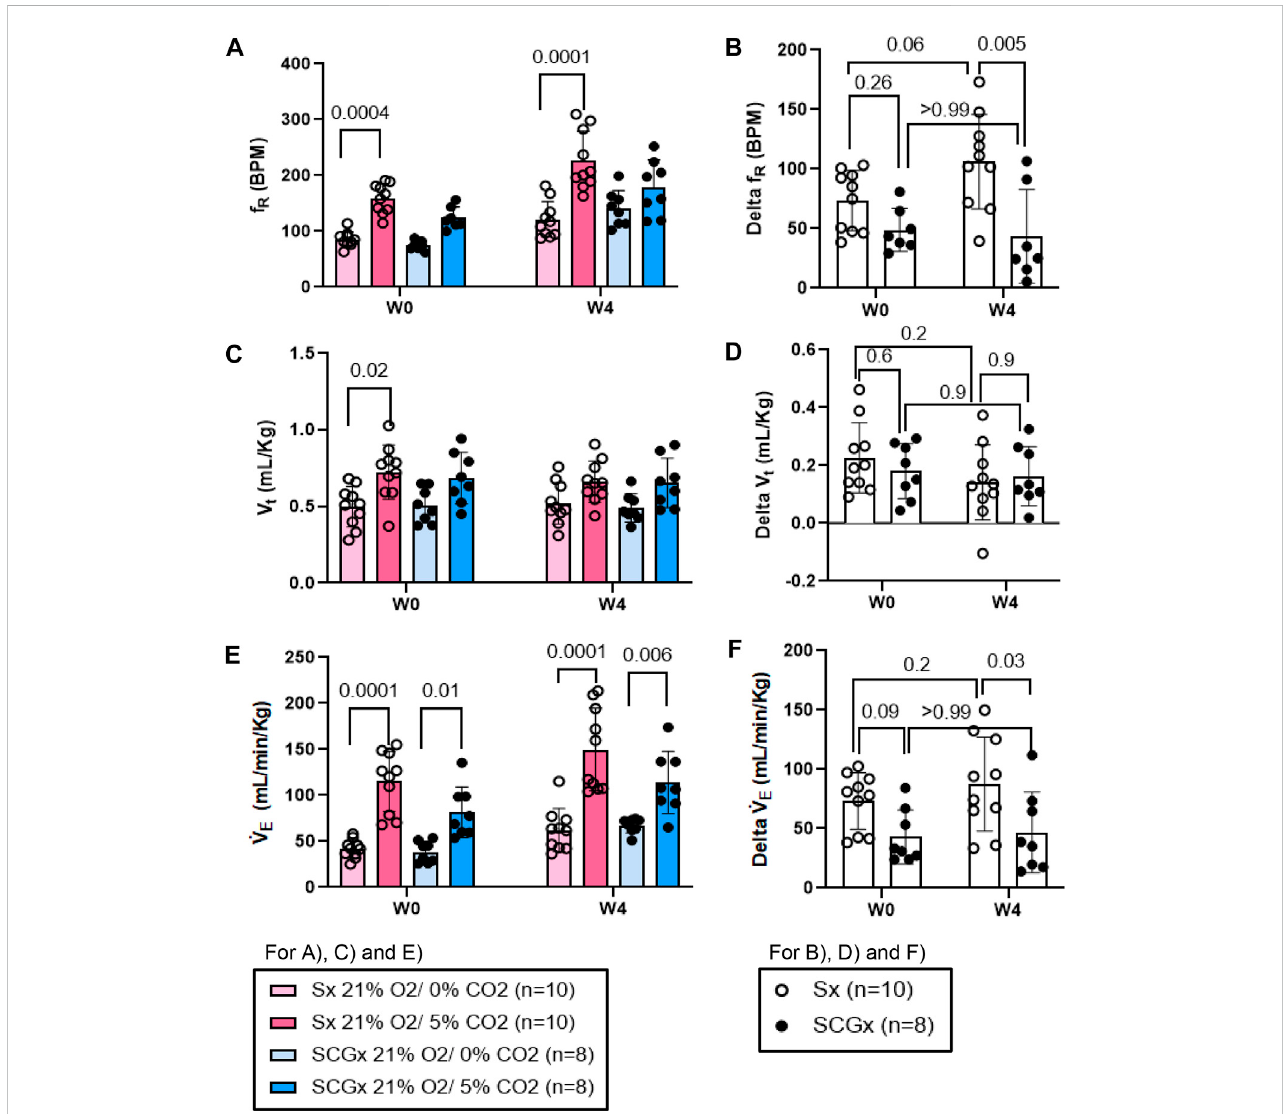
FIGURE 6 Effect of SCGx (n = 8) on sensitized chemore fl ex activity on ventilatory parameters in response to normoxic-hypercapnia at W4 post-bleo. Two-way ANOVA was applied using Bonferroni multiple comparison, Values are mean ± SD; (A) Respiratory rate (f R ); (B) Delta f R ; (C) Tidal volume (V t ); (D) Delta V t ; (E) Minute ventilation (V _ E ); (F) Delta V _ E